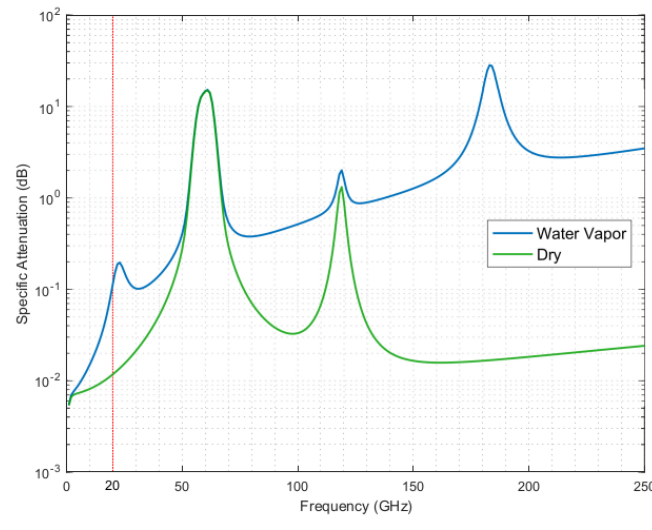
Figure 2. Atmospheric absorption for dry air and air containing water vapor [5].